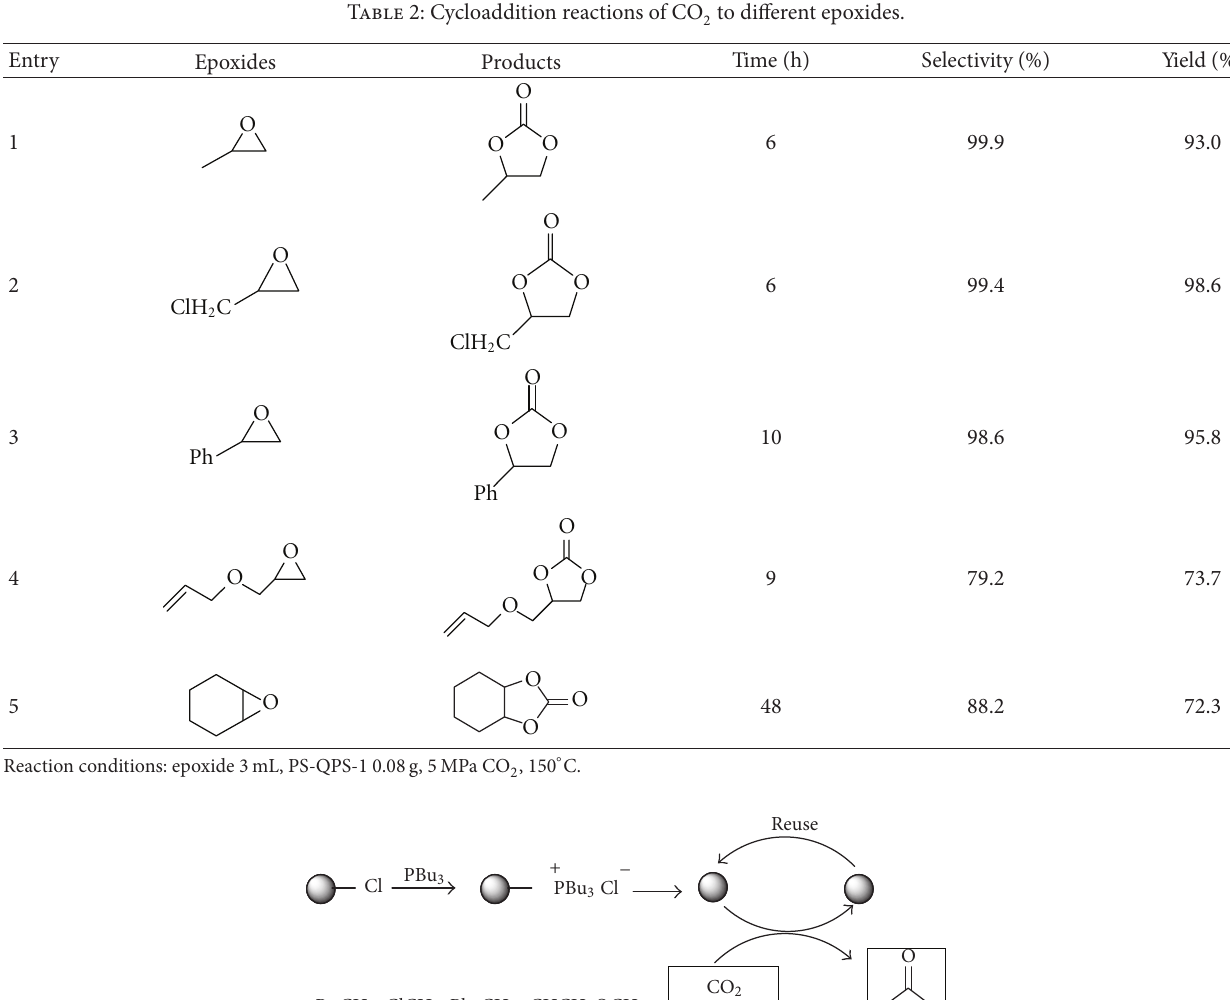
T 2: Cycloaddition reactions of CO